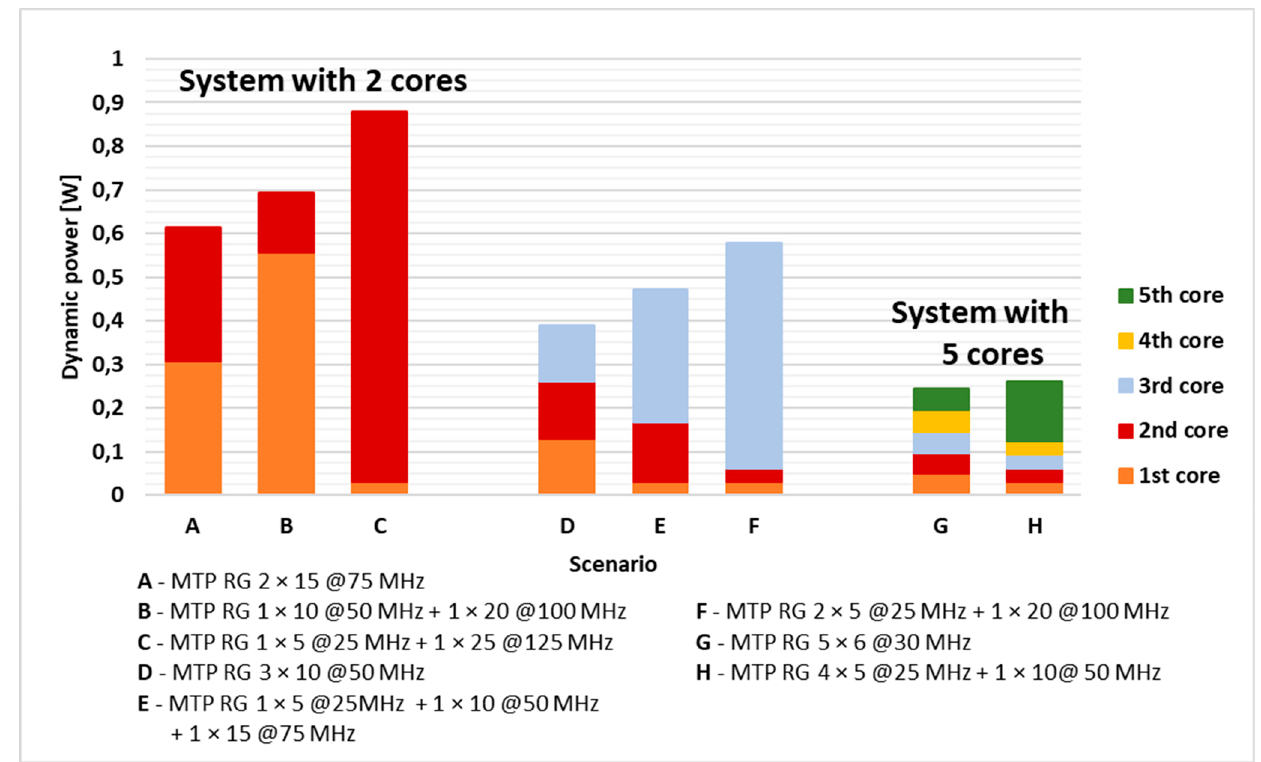
Figure 18. Comparison of the total dynamic power consumed by mixed structures for a different number of cores and various configurations of cores (all cases for SP = 150). Table 5. Comparison of the results obtained for STP CG and MTP RG with [26].